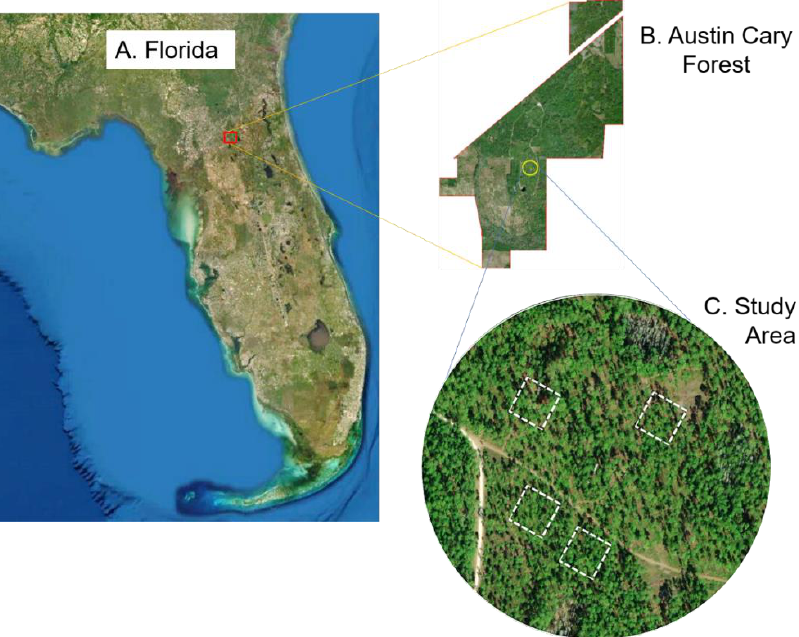
Figure 1. Images depicting ( A ) map of the state of Florida, USA extracted from world imagery basemap in ArcGIS; ( B ) location of Austin Cary Forest within Florida, and ( C ) the four 50 × 50 m permanent plots (white squares) that were used to monitor overstory dynamics and where the five understory samplings per plot were placed (locations not shown).